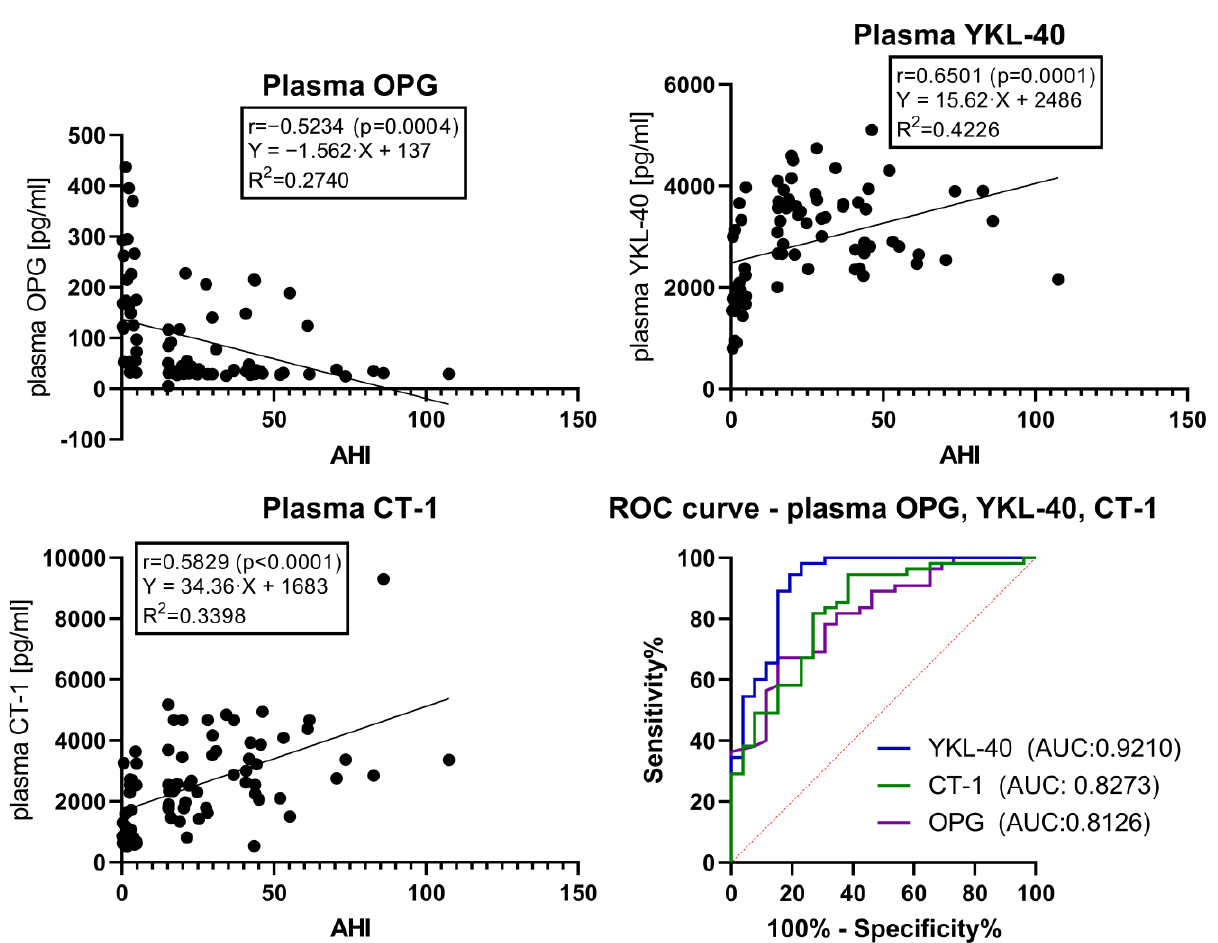
Figure 2. Simple linear regression graphs of the concentrations of OPG, YKL-40, and CT-1 in the plasma. ROC curves of the concentrations of OPG, YKL-40, and CT-1 in the plasma. The results of Spearman correlation analysis are expressed as r values and the level of statistical significance ( p ). The values of r with p < 0.05 were considered statistically significant. The coefficient of determination is expressed as R 2 . The simple linear regression models for serum OPG, YKL-40, and CT-1 use AHI as a single explanatory variable. The Receiver Operator Characteristic curve analysis is calculated for all subjects in classifying for OSA and non-OSA groups. Abbreviations: OSA, Obstructive Sleep Apnea; OPG, Osteoprotegerin; YKL-40, Chitinase-3 like protein-1; CT-1, Cardiotrophin-1; AHI,